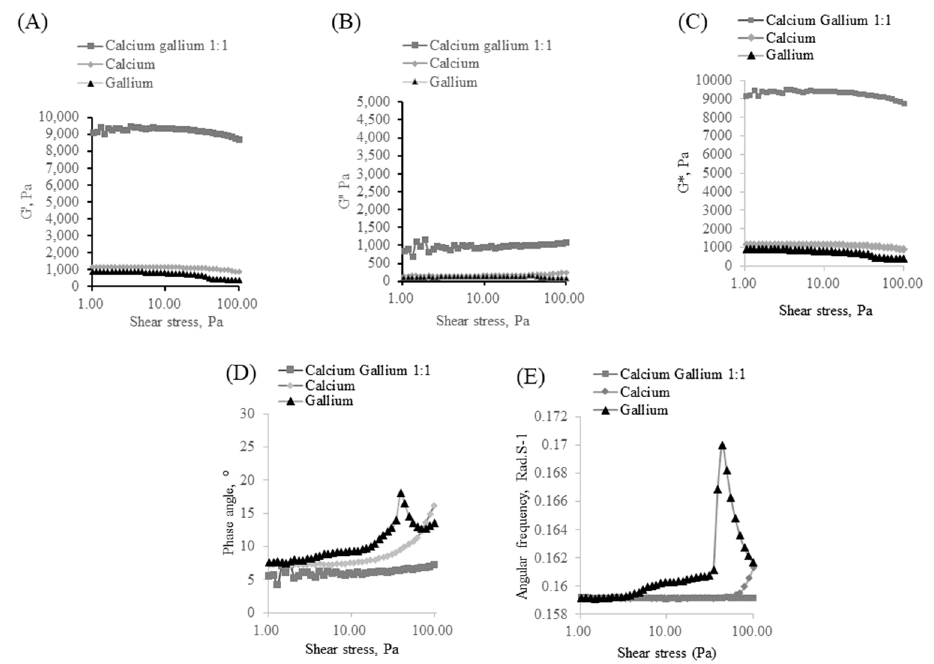
Figure 3. (A , B ) showing the changes in average G ′ and G ″ with respect to increasing shear stress for calcium alginate, gallium alginate and calcium gallium alginate 1:1. ( C ) Comparison of average complex modulus (G*) values between calcium alginate, gallium alginate and calcium gallium alginate 1:1. ( D ) Comparison of average phase angle values between calcium alginate, gallium alginate and calcium gallium alginate 1:1. ( E ) Comparison of average angular frequency values between calcium alginate, gallium alginate and calcium gallium alginate 1:1.